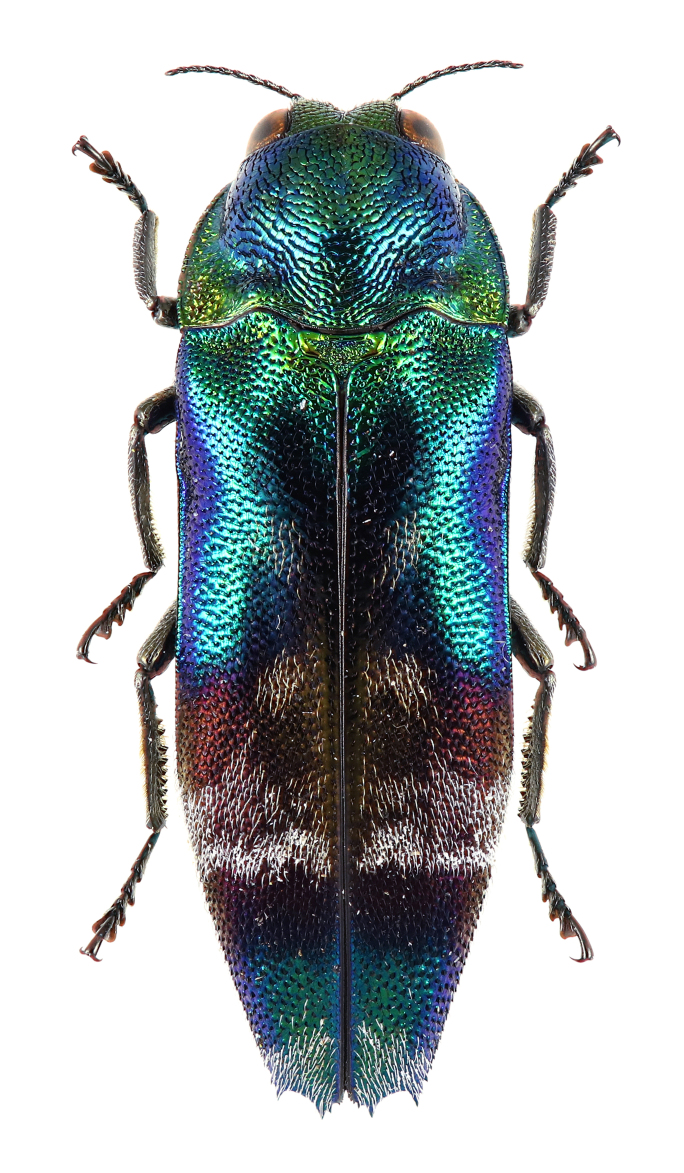
Coraebus
hastanus.